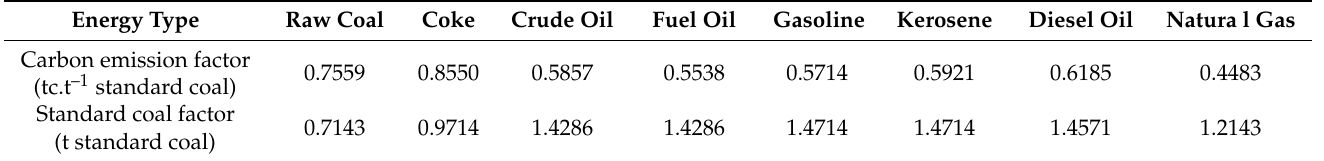
Table 2. Carbon emission coefficient for each type of